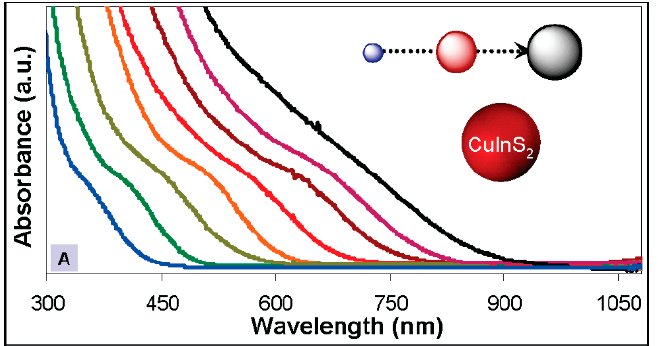
Figure 2. The emission of copper indium sulfide (CIS) QDs with different diameters obtained under different reaction temperatures. Reproduced with permission from [94]. Copyright American Chemical Society, 2009. Composition-dependent band-gap.